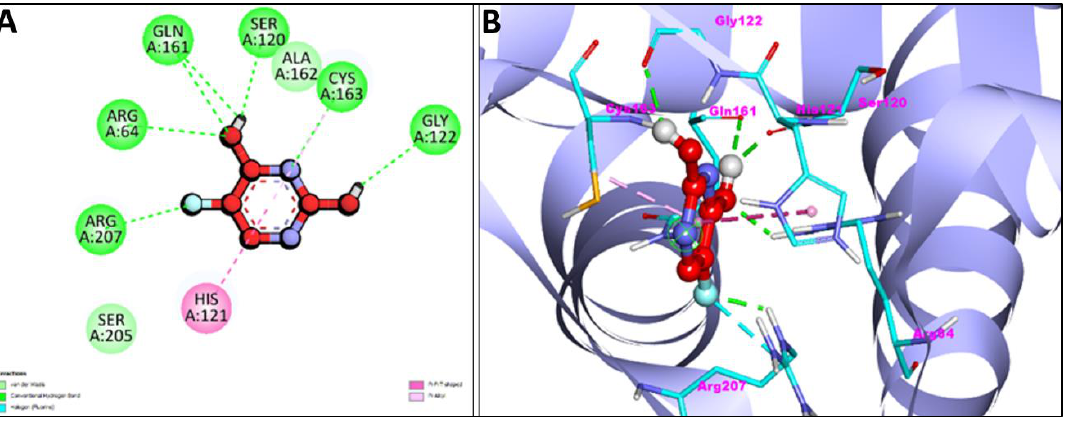
Figure 11. 2D ( A ) and 3D ( B ) representation of interaction of anti-cancerous drug fluorouracil and caspase-3 protein (purple color with ribbon pattern) (PDB:4QU8).